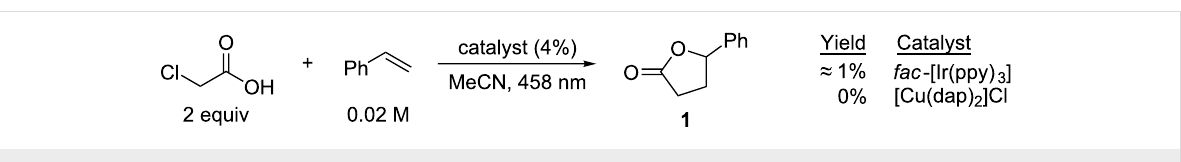
Scheme 2: Initial attempts for lactone formation by photoredox